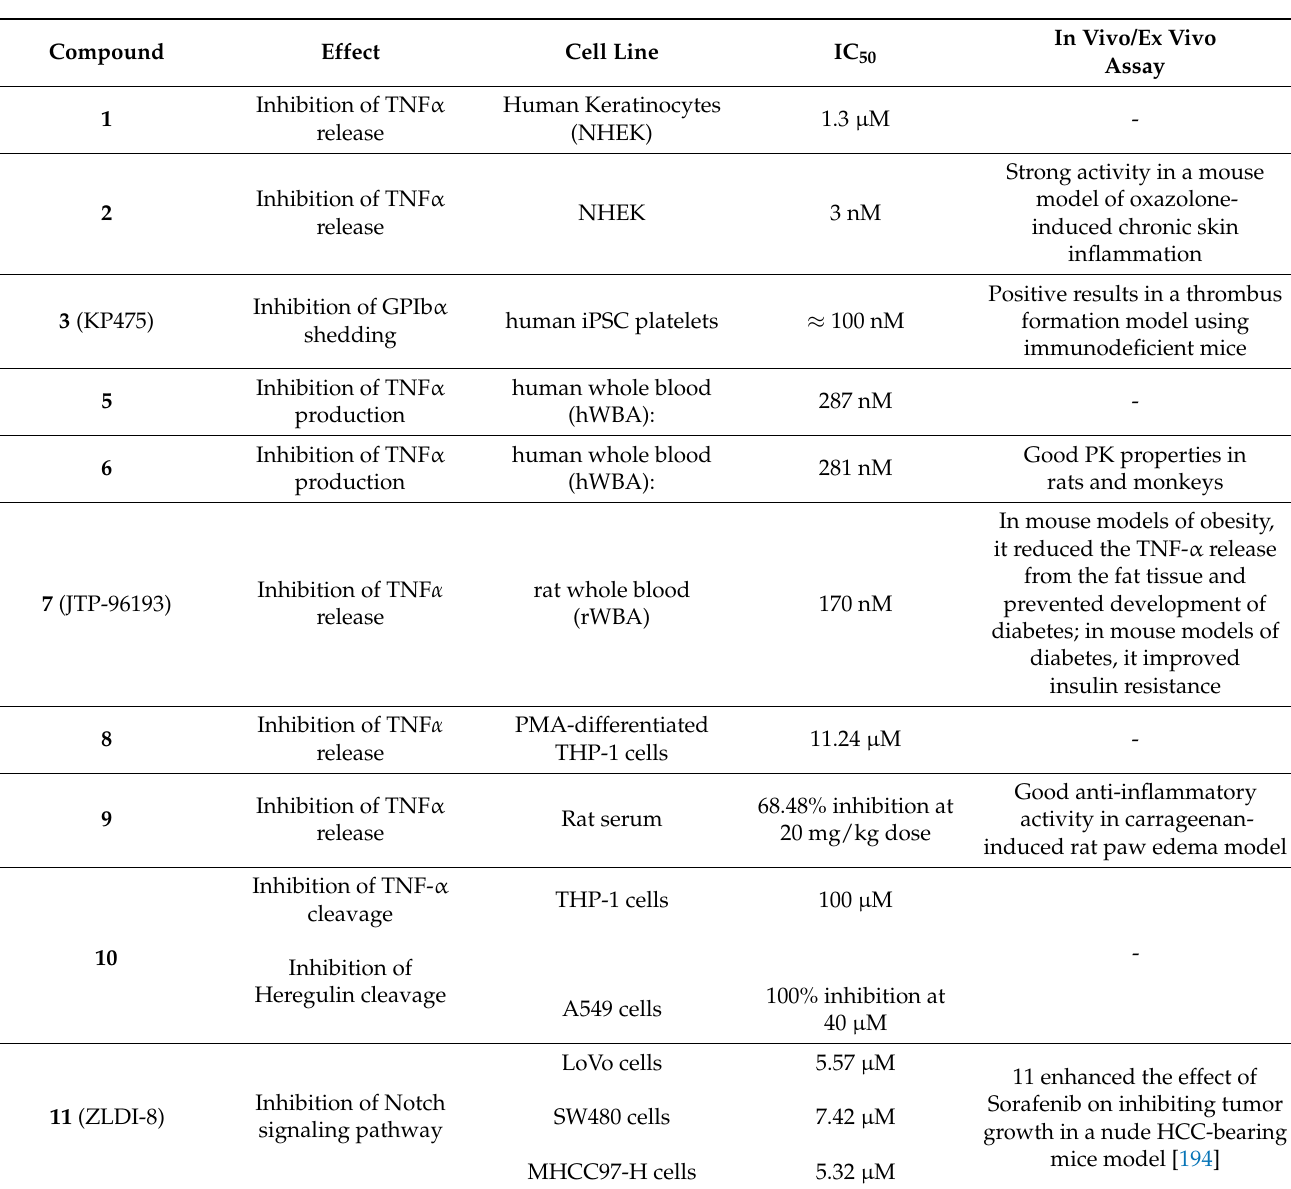
Table 4. Reported cell data (IC 50 ) and in vivo/ex vivo data for selected ADAM17 inhibitors.